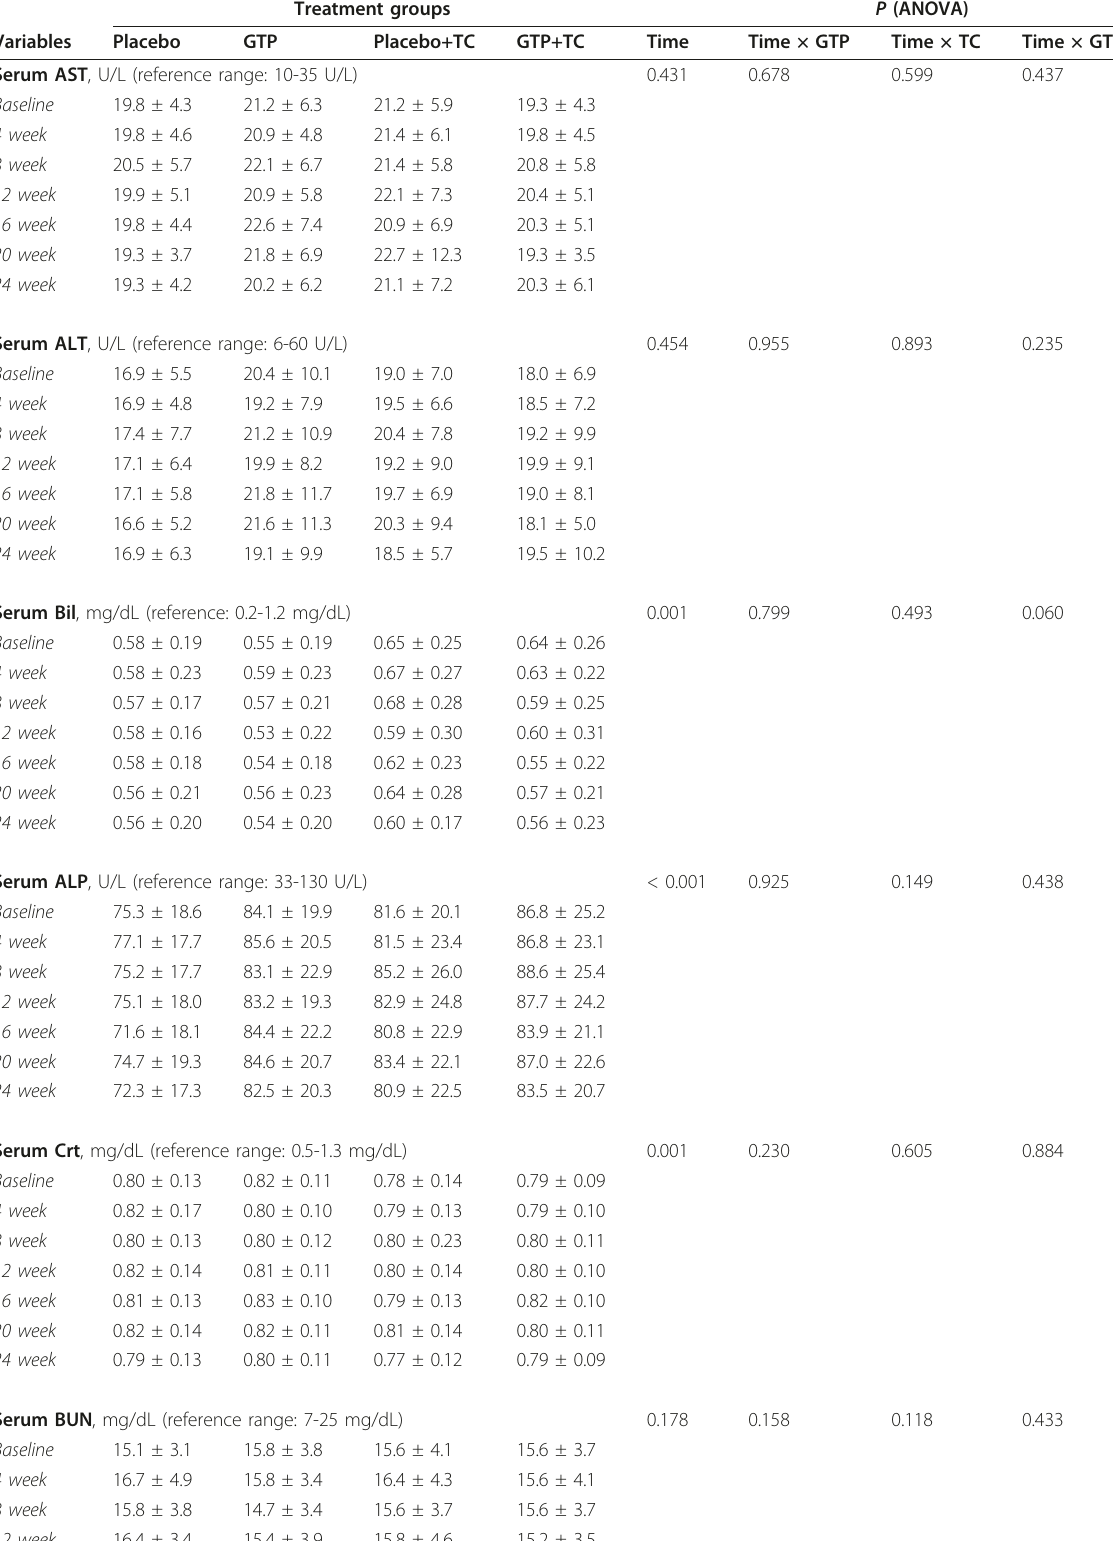
Table 2 Effect of green tea polyphenols supplementation and Tai Chi exercise on blood chemistry in postmenopausal osteopenic women Treatment groups P (ANOVA)